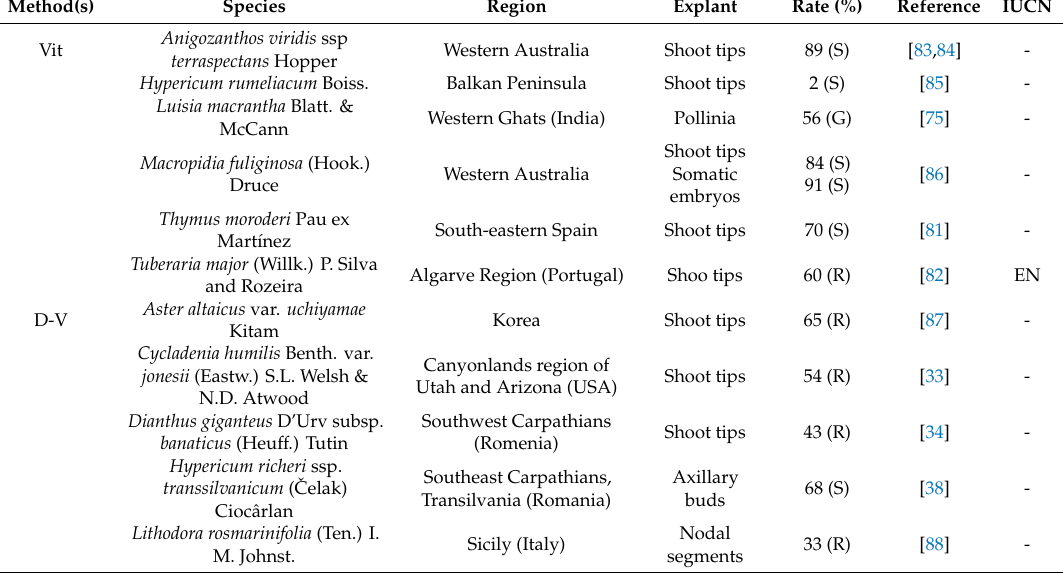
Scientific publications on cryopreservation of endemic plant species, by